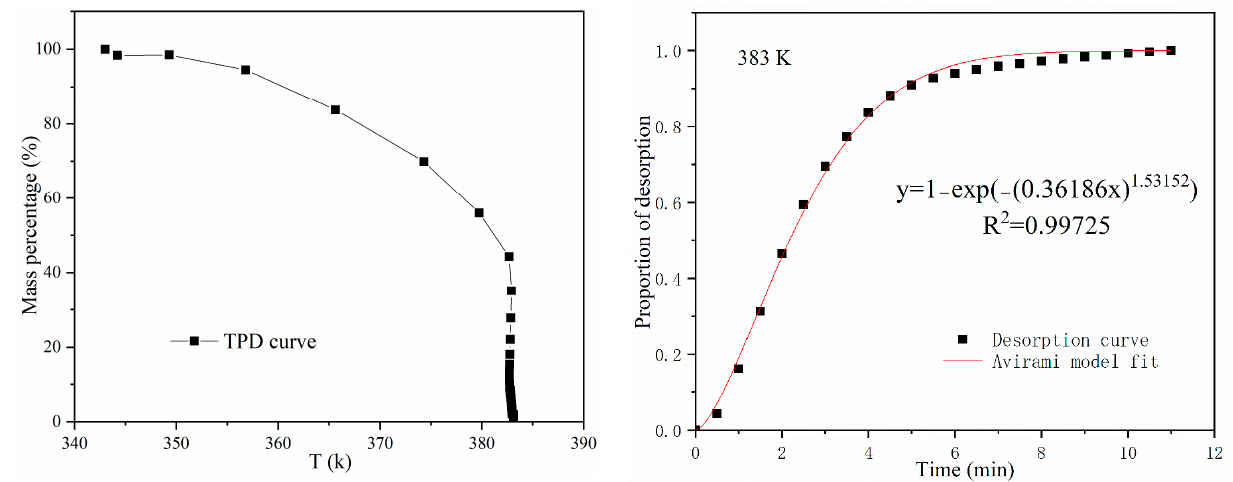
Figure 9. Results of TPD and desorption experiment at 383 K.